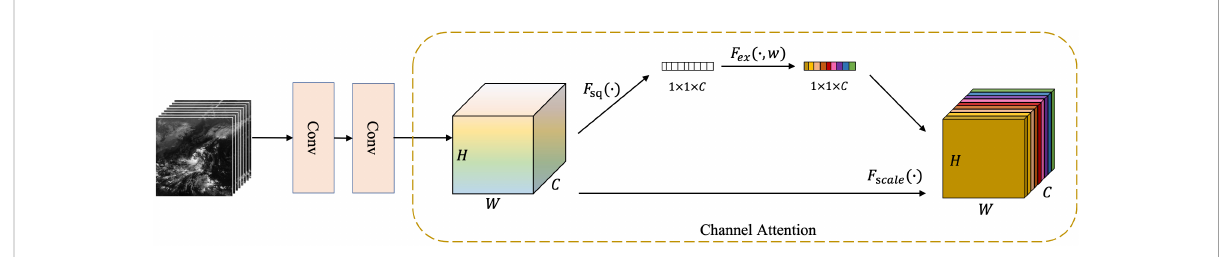
FIGURE 4 Feature enhancement module: two simple convolutional layers and a channel attention